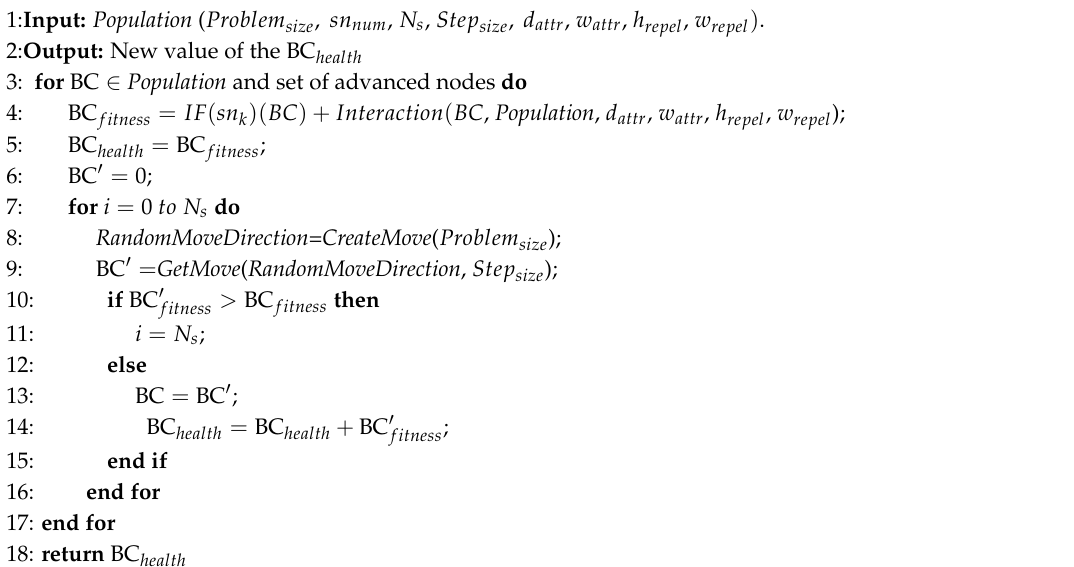
Algorithm 2: An algorithm for the chemotaxis